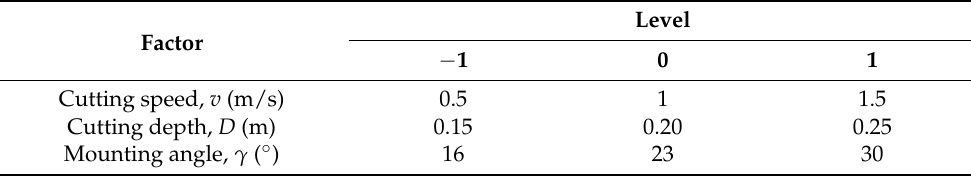
Figure 5. Diagram ( a ) of soil failure pattern and the phenomena in simulations ( b ) and soil bin ex- periments ( c ). r refers to the soil rupture distance, D refers to the working depth, ζ refers to the soil rupture angle, and α refers to the rake angle.